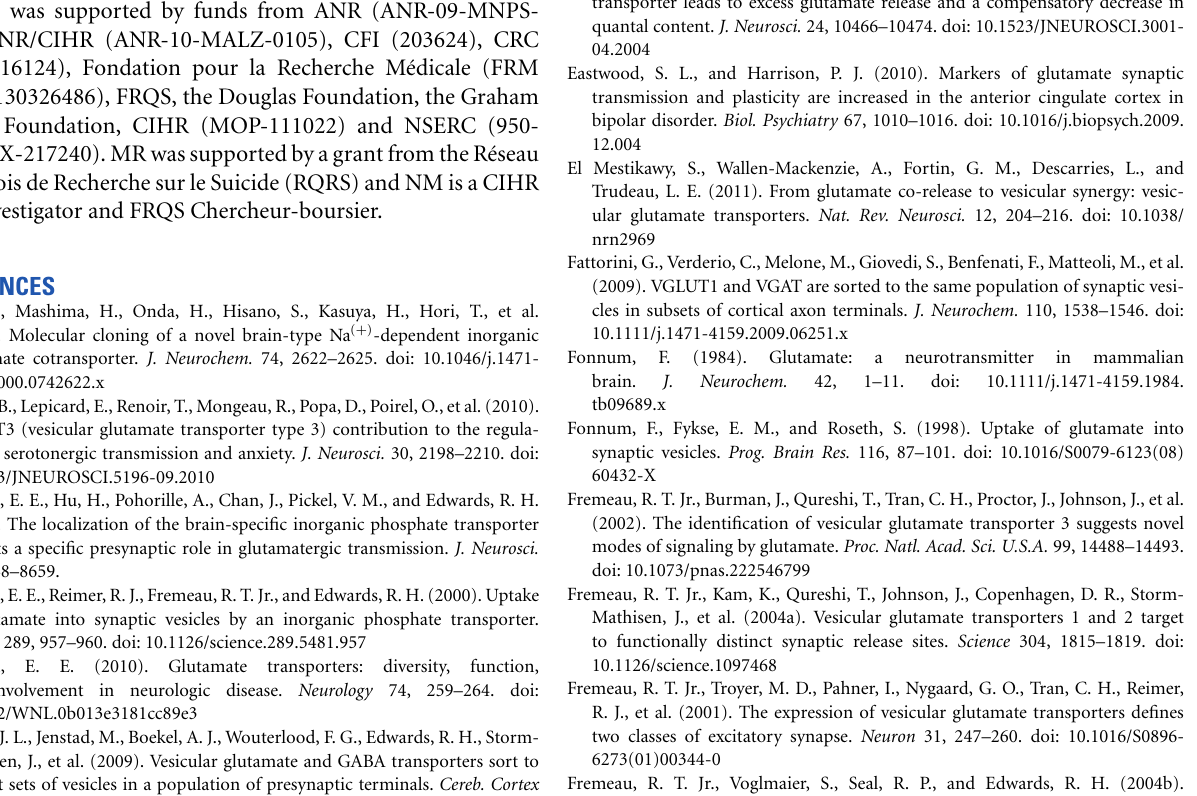
of the Douglas-Bell Canada Brain Bank: Maâmar